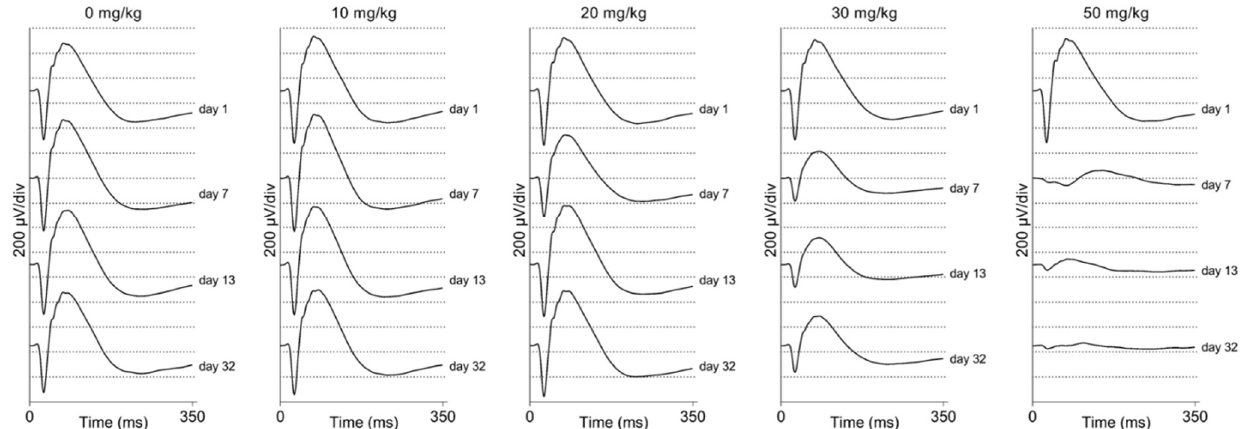
Figure 5. Averaged scotopic electroretinograms are shown for Brown Norway rats ( n = 4 per group). The averaged traces per treatment group and per day of follow-up are plotted. No difference could be observed between the 10 mg/kg group and the control group by eye. A temporary effect was seen for the 20 mg/kg group: a slightly decreased response was seen a week post-injection. A moderate effect was seen for the 30 mg/kg group: decreased responses were observed from seven-days post-injection onwards. Direct and drastic effects were observed for the higher treatment group (50 mg/kg). The ERG responses were hardly recordable from one-week post-injection onwards. Similar effects were observed in the ERG recordings from C57BL/6J mice (Figure 4).